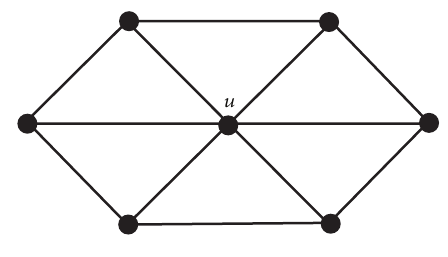
Figure 3: The wheel graph 𝑊 6